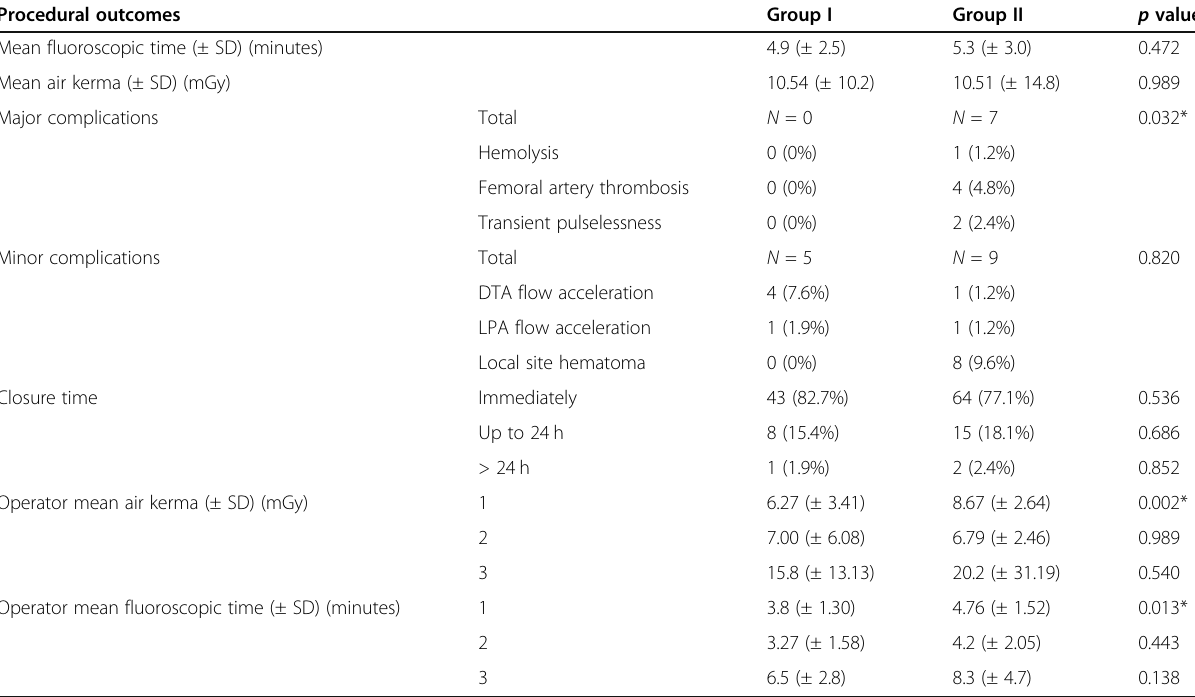
Table 2 Outcomes of the procedure in the two groups Procedural